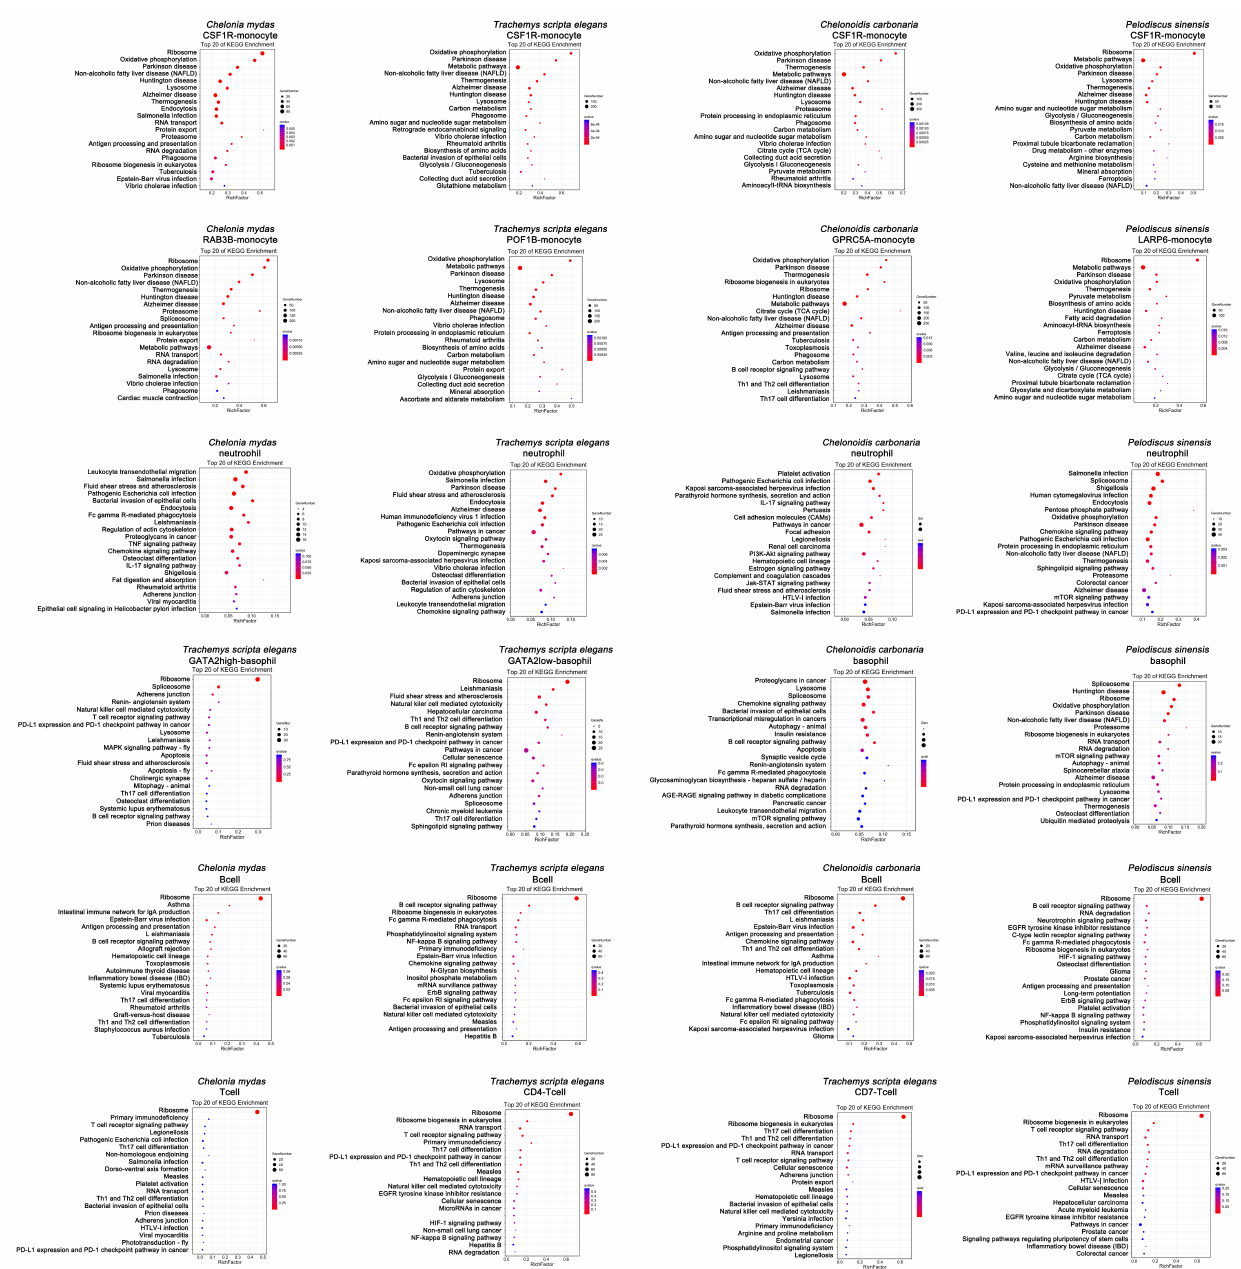
Figure 5. KEGG enrichment analysis of monocytes, neutrophils, basophils, B cells, and T cells in